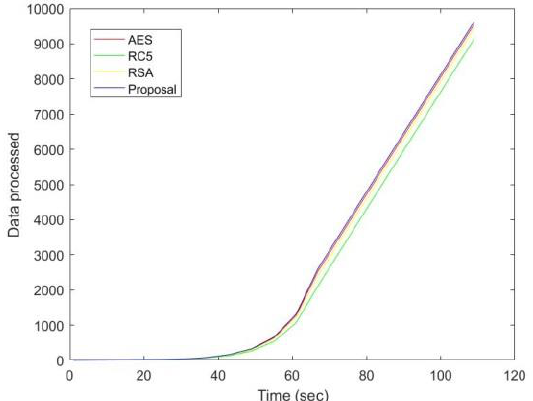
Figure 5. Performance of data processed (megabytes) comparison of the AES, RC5, RSA, and proposed model.